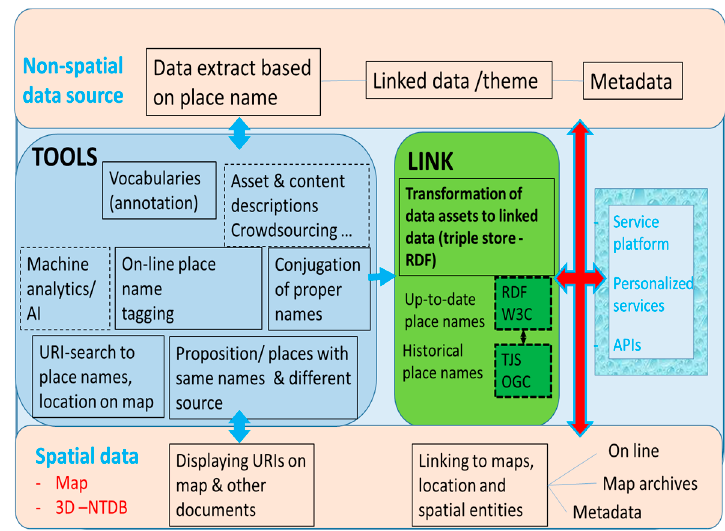
Figure 1. Our proposed referencing framework for improved management of semantics of digital assets with geographical characteristics, either classical SDI components or any other asset, and the needed ontologies. The spatial features are used to specify a CWO or an OWA.